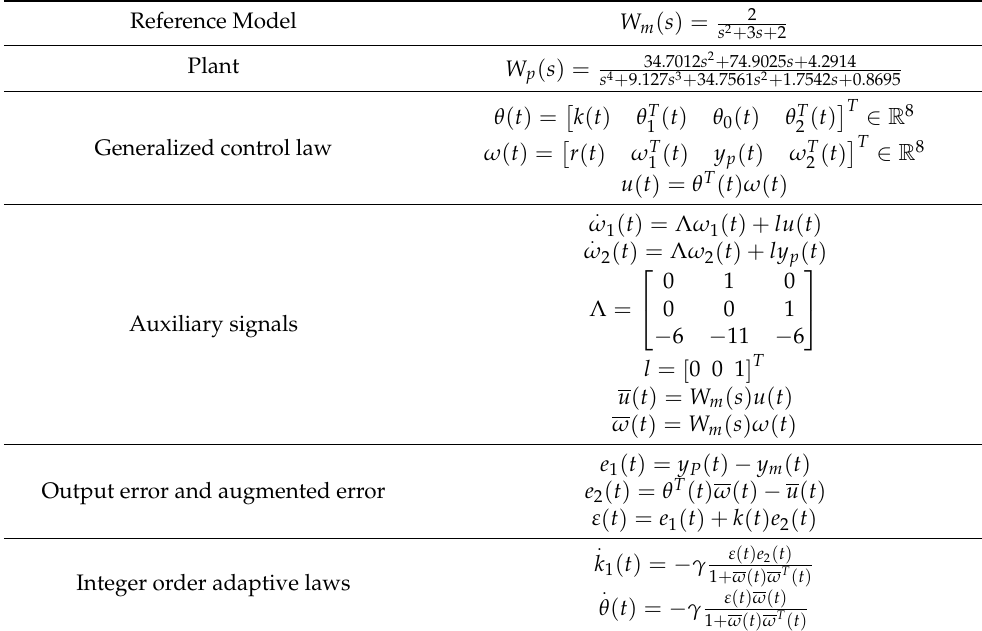
Table 6. Implementation details of the general IO-DMRAC controller for the case n ∗ ≥